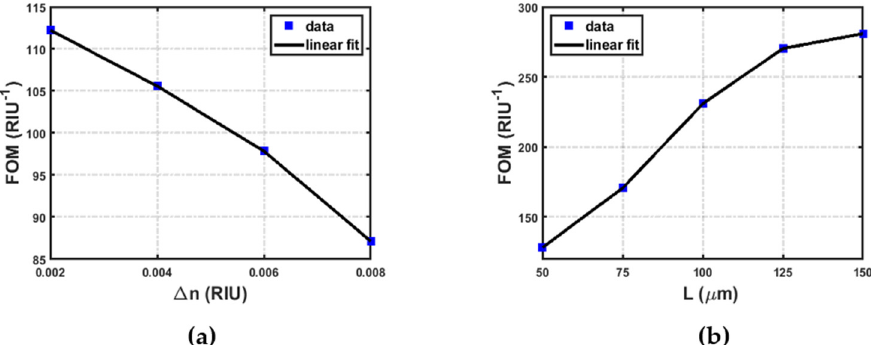
Figure 5. ( a ) LT-MZI sensor FOM calculated at different medium index changes ( Δ n) with L = 50 µm; ( b ) LT-MZI sensor FOM versus interferometer arm length.